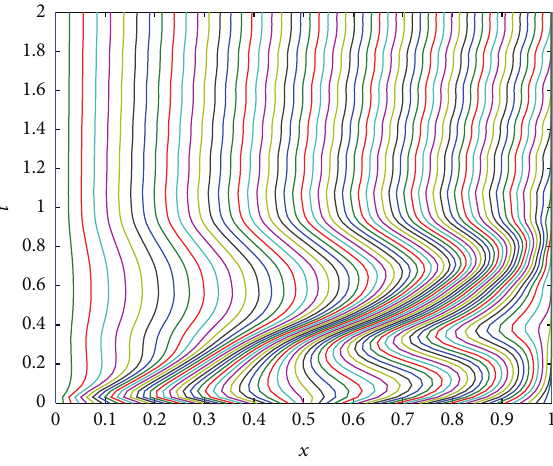
Figure 5: Mesh trajectory for 𝜀 = 2 −20 , 𝜏 = 0.05 , and 𝑁 = 64 .